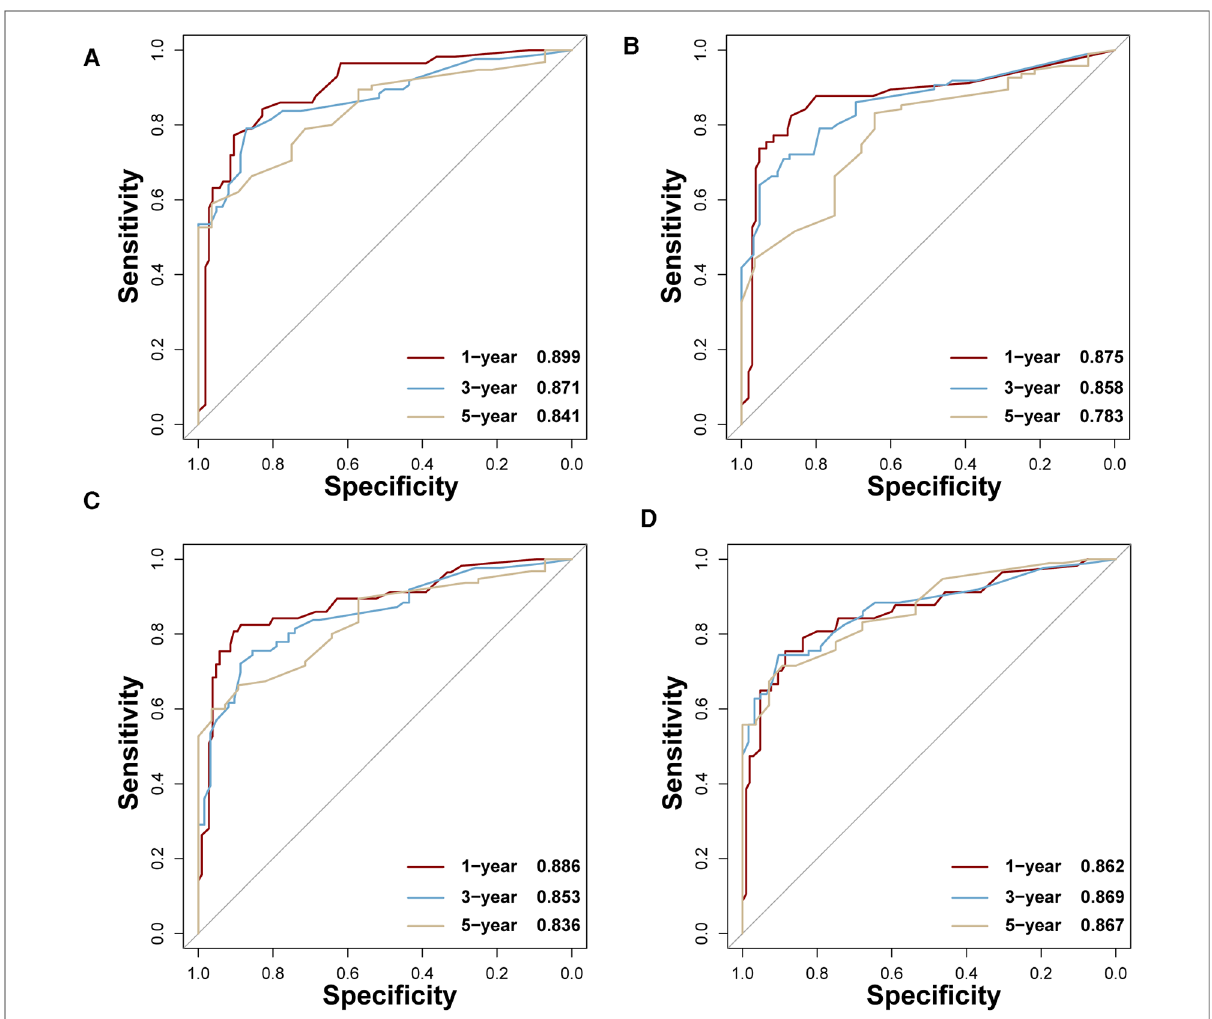
FIGURE 5 AUCs of four ML-based models for the test set at 1-, 3-, and 5-year points. ( A ) BP-ANN, ( B ) RF, ( C ) SVM, ( D ) NBC.